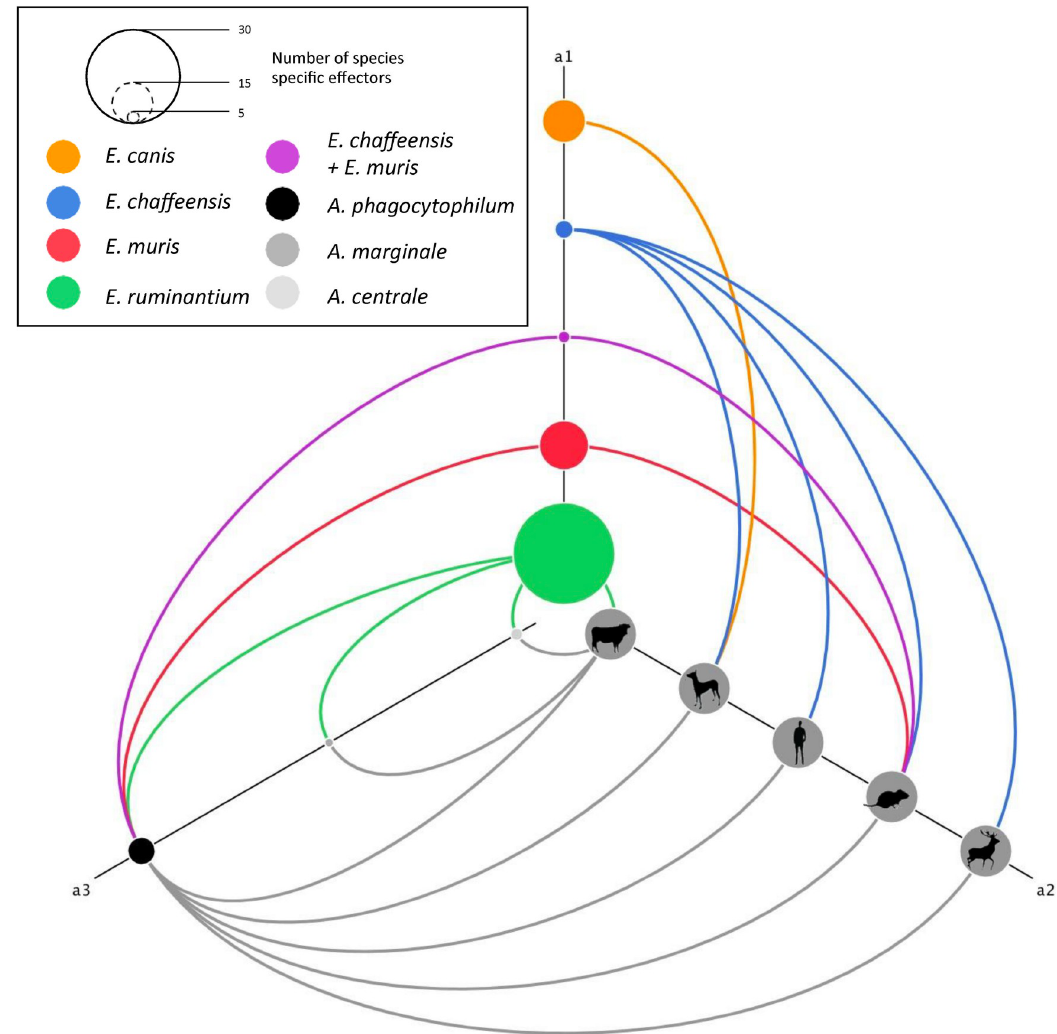
Fig 3. Network analysis of Anaplasmataceae species-specific pT4Es and host range suggests the existence of host-specific pT4Es. This network of species-specific pT4Es was drawn using the hive plot algorithm, which is a rational visualization method for drawing networks based on their structural properties. Nodes are mapped to and positioned on radially distributed linear axes and edges are drawn as curved links. Ehrlichia species-specific pT4Es are represented by nodes on the a1 axis of the hive plot. The size of each node is linked to the number of species-specific pT4Es for a given Ehrlichia species which is colour coded as shown in the upper left rectangle: E . chaffeensis str. Arkansas (blue), E . canis str. Jake (orange), E . ruminantium str. Gardel (green) and E . muris AS145 (red). Purple node is the combined subset of pT4Es specific to E . chaffeensis str. Arkansas and E . muris AS145. Anaplasma species-specific pT4E are represented by nodes on the a3 axis whose size and nuance of grey depend on the Anaplasma species. The different hosts of these 7 Anaplasmataceae bacteria are represented by grey nodes on the a2 axis. Curved links a1-a2 and a3-a2 show the putative host specificity of each bacterium. Links between a1-a3 represent shared host-specific effectors. The colour of each link is related to the node from which it